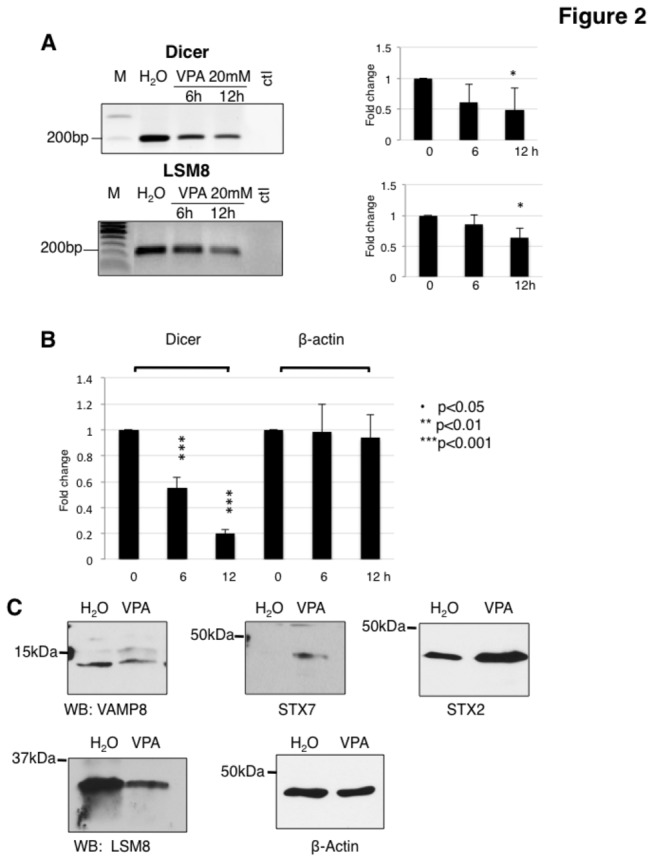
Validation of VPA induced changes.
A. Effect of VPA on dicer and LSM8 mRNA expression after 6 and 12 hours of treatment, determined by RT-PCR (*: p < 0.05, from three independent experiments). H2O was used as negative control (ctl).
B. Real time PCR analysis of DICER mRNA expression after VPA treatment for six and 12 hrs.
C. Changes on protein level determined by Western Blot. HEK293 cells were treated for 16 hours with 20 mM VPA. Total cell lysates were separated by SDS page and analyzed using the antisera indicated. Beta-actin was used as a loading control. The mRNA changes of these genes are shown in Figure S3, VAMP8: downregulated, STX7: upregulated; STX2: downregulated; LSM8: downregulated.